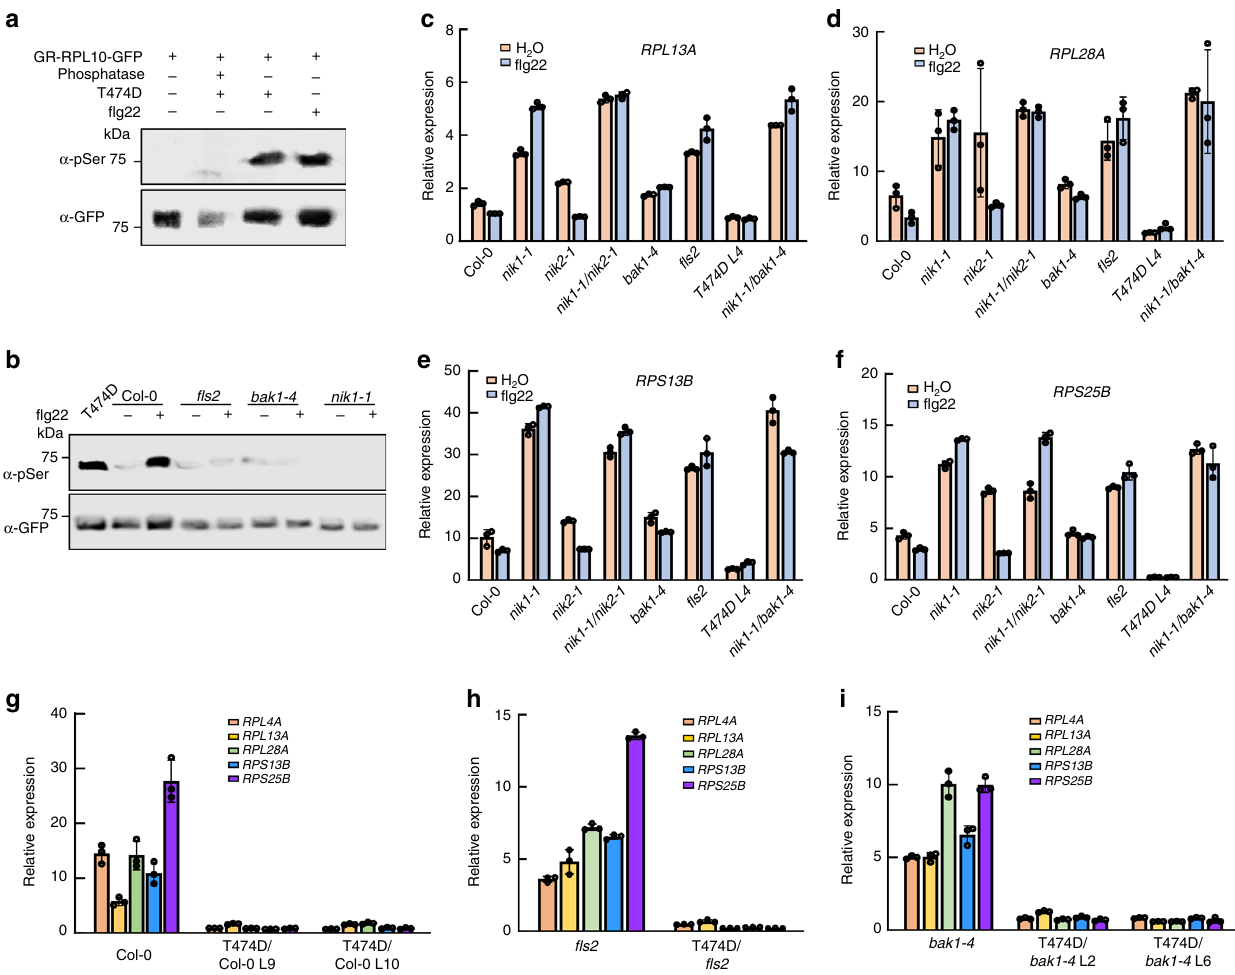
Fig. 6 Flg22 induces RPL10 phosphorylation and the translation control branch of antiviral signalling in a NIK1-, FLS2/BAK1-dependent manner. a Flg22 treatment induces RPL10 phosphorylation. RPL10 phosphorylation was detected by immunoblotting with an α -phosphoserine ( α -pSer) antibody (top) and RPL10 protein is shown using an α -GFP antibody. The experiment was repeated three times with identical results. b RPL10 phosphorylation requires the FLS2/BAK1 receptor complex. RPL10 was expressed in protoplasts isolated from Col-0, fl s2 , nik1-1 or bak1-4 mutants for 12 h, and then fl g22 treatment was performed. T474D-mediated RPL10 phosphorylation was used as a positive control. The experiment was repeated twice with similar results. c – f Flg22- induced downregulation of RP13A , RPL28A , RPS13B and RPS25B is dependent on NIK1 and FLS2/BAK1. Seedlings of indicated plants were treated with fl g22 for 3 h, and expression of ribosomal genes was analysed by qRT-PCR. Data are shown as the mean ± SE ( n = 3). g Overexpression of NIK1-T474D in WT Col-0 suppresses expression of ribosomal genes. qRT-PCR analysis of RP expression levels in Col-0- and T474D-overexpressing lines. h , i FLS2 and BAK1 are not required for the suppression of ribosomal genes by NIK1-T474D overexpression. Ribosomal marker gene expression levels were detected in fl s2 , bak1-4 mutants and NIK1-T474D-overexpressing lines. The respective 95% con fi dence interval limits were estimated based on bootstrap resampling replicates of three independent ( n = 3) experiments and three technical repeats. Source data are provided as a Source Data fi